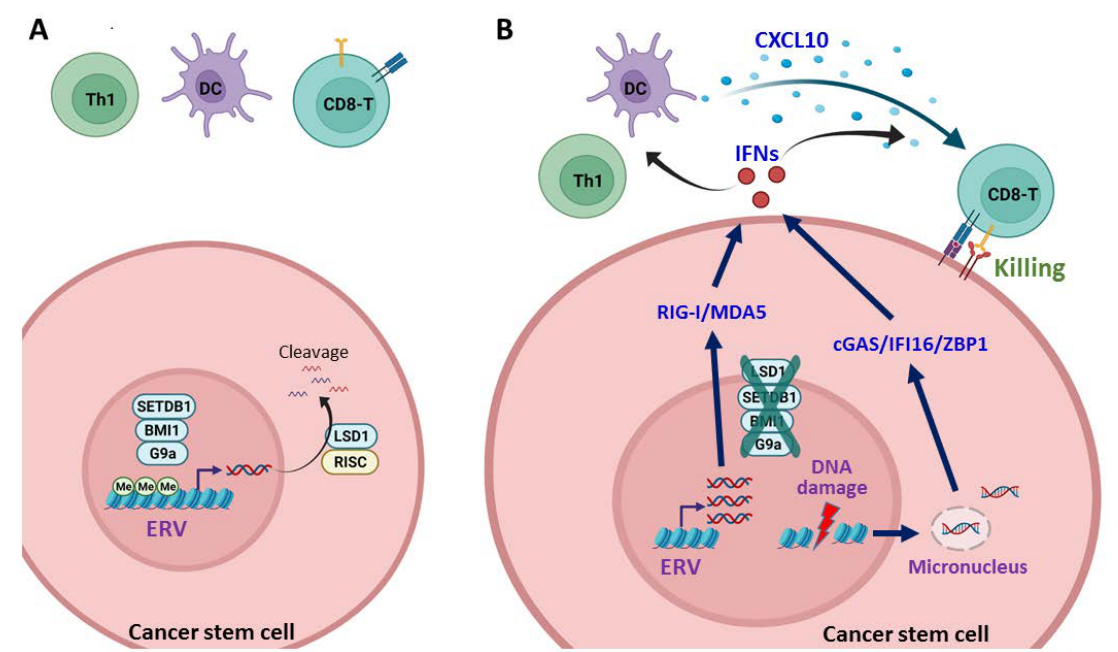
Figure 3. Inhibition of epigenetic modifiers in the induction of interferon response and recruitment of CD8+ T cells. ( A ) The histone modifiers LSD1, SETDB1, BMI1, and G9a are overexpressed in cancer stem cells (CSCs), leading to silencing of endogenous retrovirus (ERV) by the hypermethylation and degradation of cytosolic RNA by the RNA-induced silencing complex (RISC). As a result, the interferon response is suppressed and the CSCs are kept away from the killing of cytotoxic CD8+ T cells; ( B ) Inhibition of LSD1, SETDB1, BMI1, or G9a results in de-repression of ERV and induction